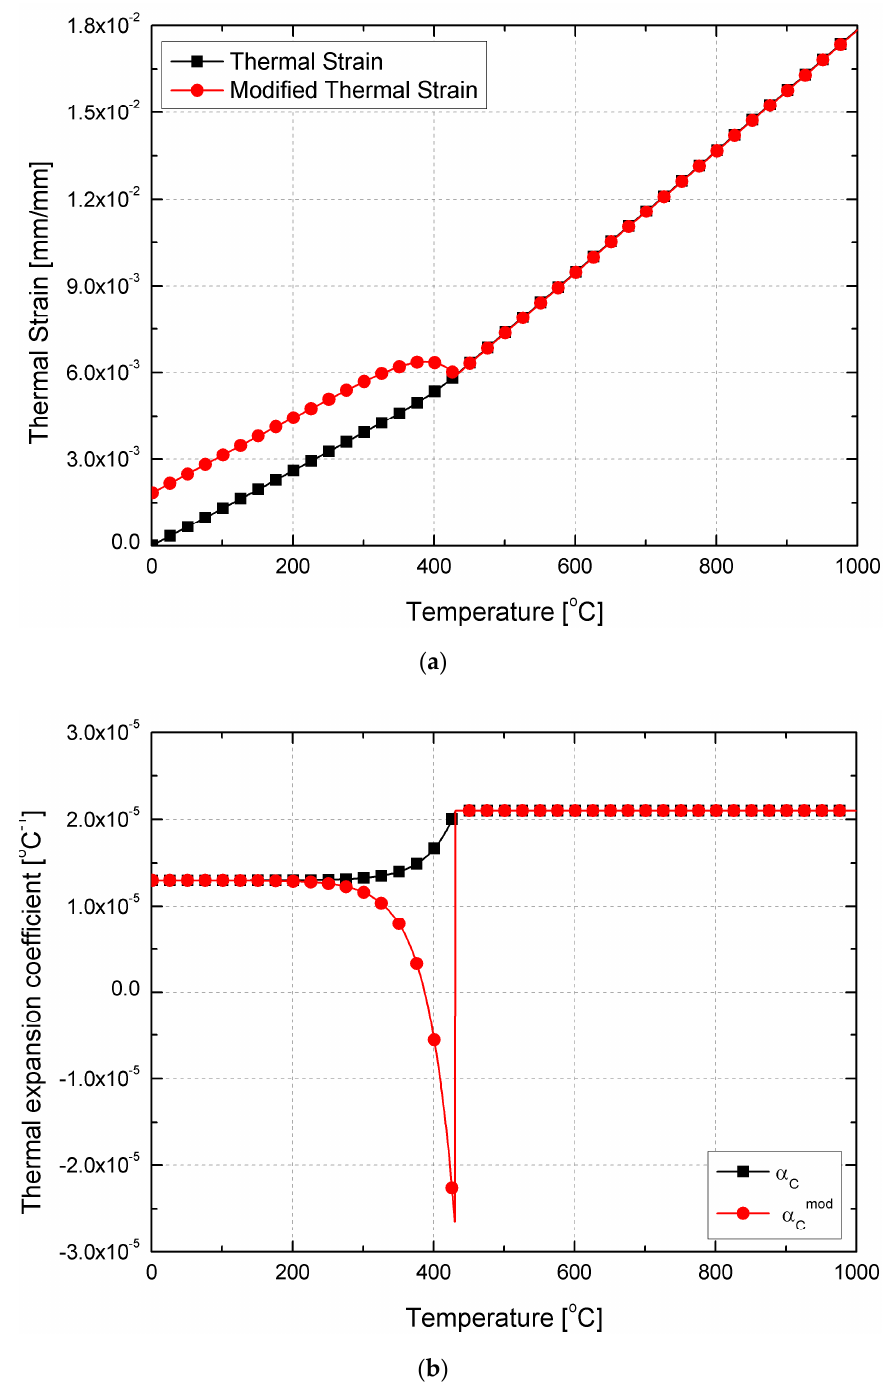
Figure 4. Modified thermal expansion coefficient and thermal strain in cooling cycle: ( a ) Thermal strain; ( b ) Thermal expansion coefficient